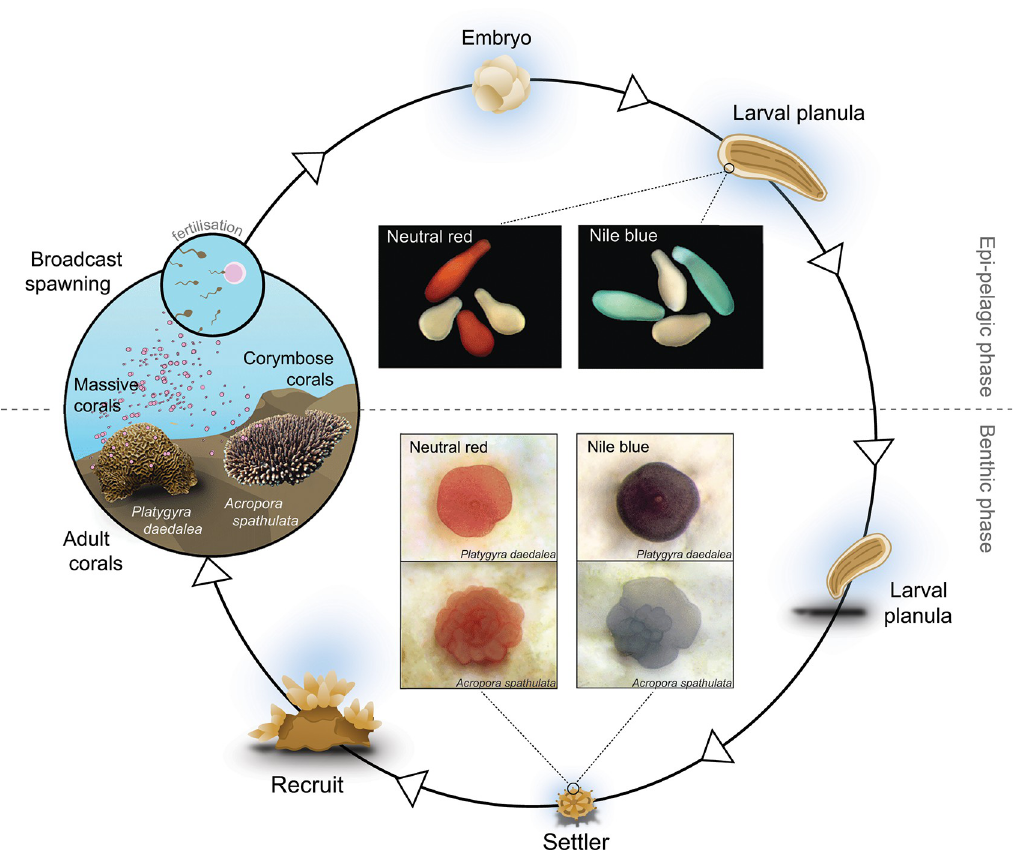
Fig 1. Life history strategy of broadcast spawning corals, from the epipelagic release phase of sperm and eggs in mass spawning to the benthic stage of larval settlement and recruitment into the population. Inset photographs are representative images of neutral red and Nile blue stains on larvae (colored vs. control unstained larvae in white) and recently settled life history phases. Clip art has been modified from [22] under a Creative Commons Attribution (CC BY) license. Images (adult, larvae, settler) supplied by